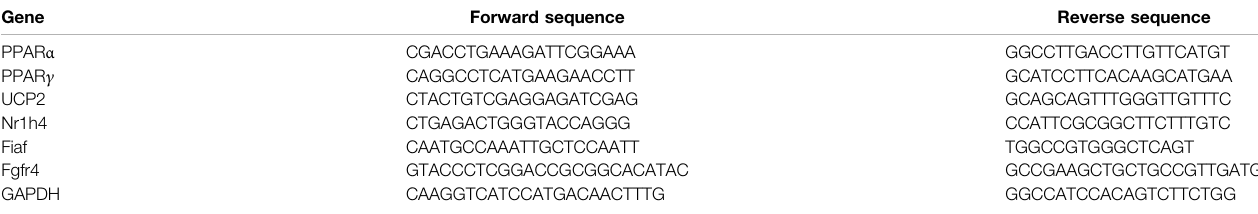
TABLE 1 | Primer sequences used for real-time PCR ampli fi